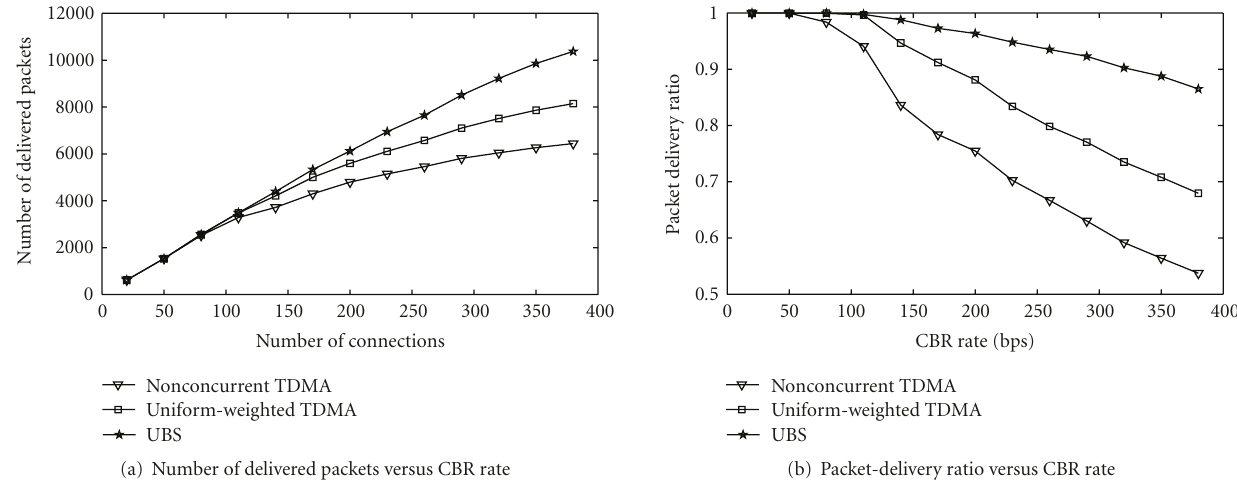
Figure 7: Simulation results with nonuniform tra ffi c scenarios averaged over 10 di ff erent 20-node network